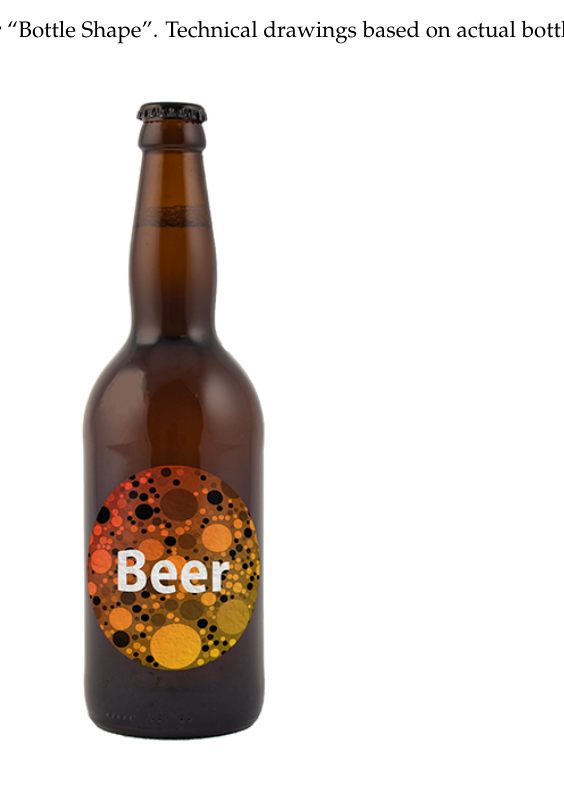
Figure 5. Example of a complete stimulus presented to the participants during the conjoint survey. Images for all possible combinations of factors and levels are given in the appendix to this